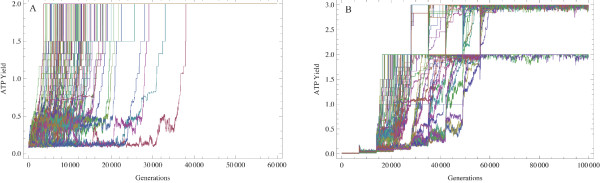
Evolution of early codes by selecting on the ATP yield. Evolution of the assignation of amino acids to adapters by selecting on the resulting ATP yield. (A) Employing only the simplest four Miller amino acids (alanine, aspartic acid, glycine and valine) 104 runs with initial random associations converged to optimise the ATP yield, in all cases reaching to the maximum of 2 moles of ATP. (B) 100 runs started from random associations to alanine and glycine and every 7000 generations a new Miller amino acid, randomly selected, was included and assigned to a random adapter. Most runs converged to optimal codes (with the maximum yield of 3 moles of ATP), but three did not.